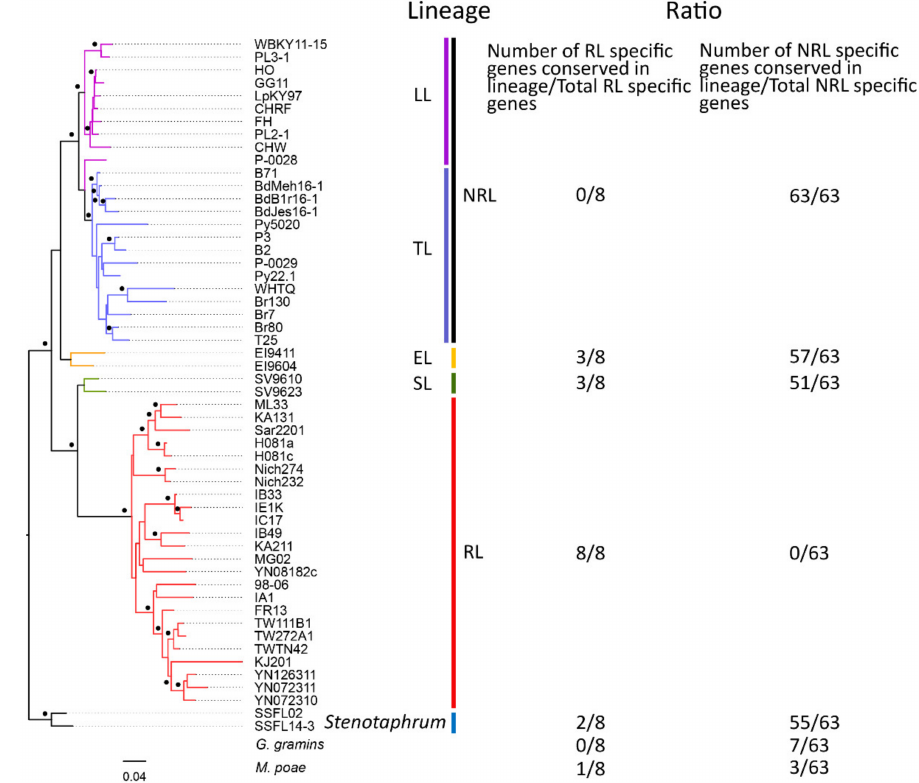
Figure 5. Maximum-likelihood phylogenetic tree, and occurrence ratio of RL and NRL specific genes in different lineages and two related species of Magnaporthaceae. The maximum-likelihood tree was constructed based on 1599 identified PAVs. Nodes with more than 90% bootstrap support were marked by dots. The isolates of different lineages were labeled with different colors according to the result of Figure S1. SL represented the Setaria lineage.